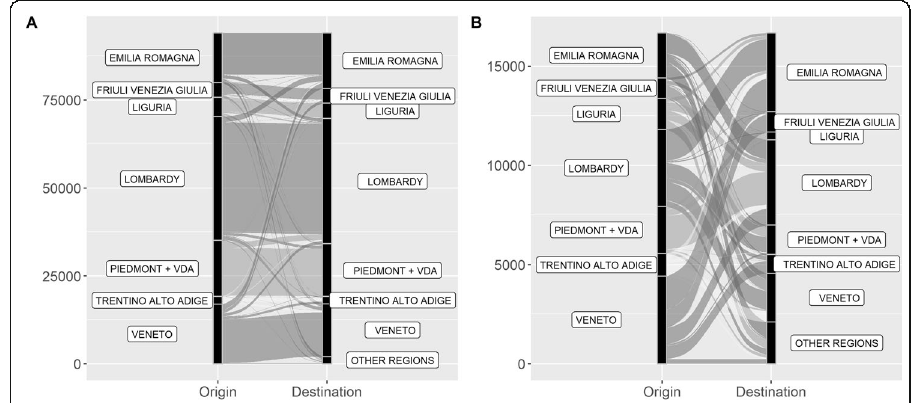
Fig. 1 Sankey plots of students ’ flows: all students in panel A ; only half-movers and movers in panel B (data refers to 2017